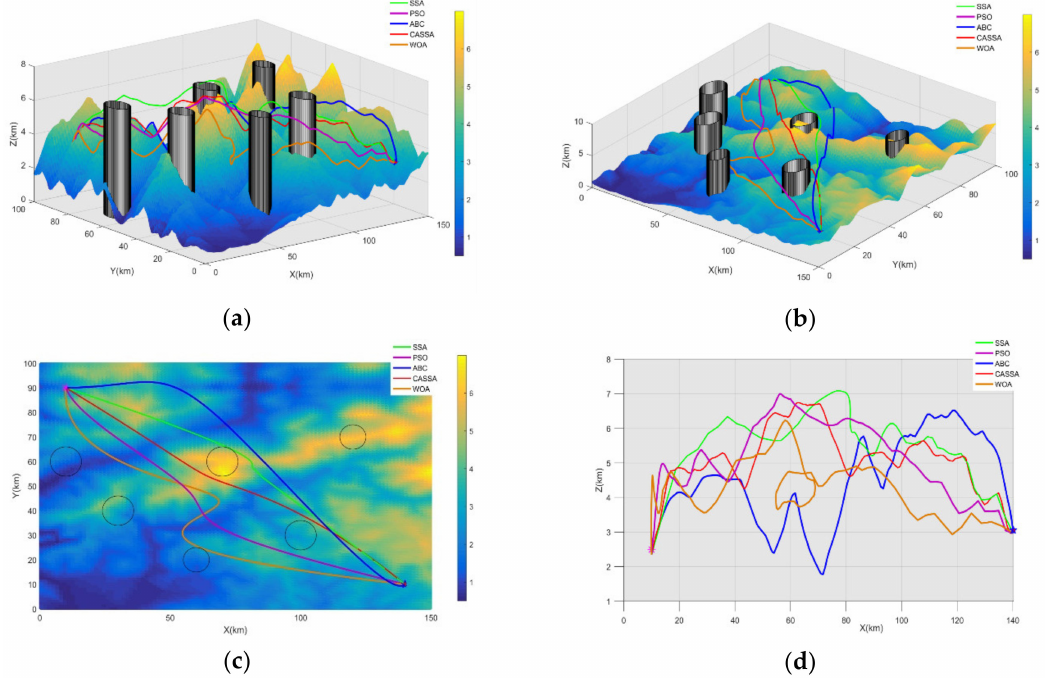
Figure 9. The best route of each algorithm. ( a , b ) Route comparison in three-dimensional space; ( c ) overhead view of Route comparison in three-dimensional space; ( d ) side view of route comparison.